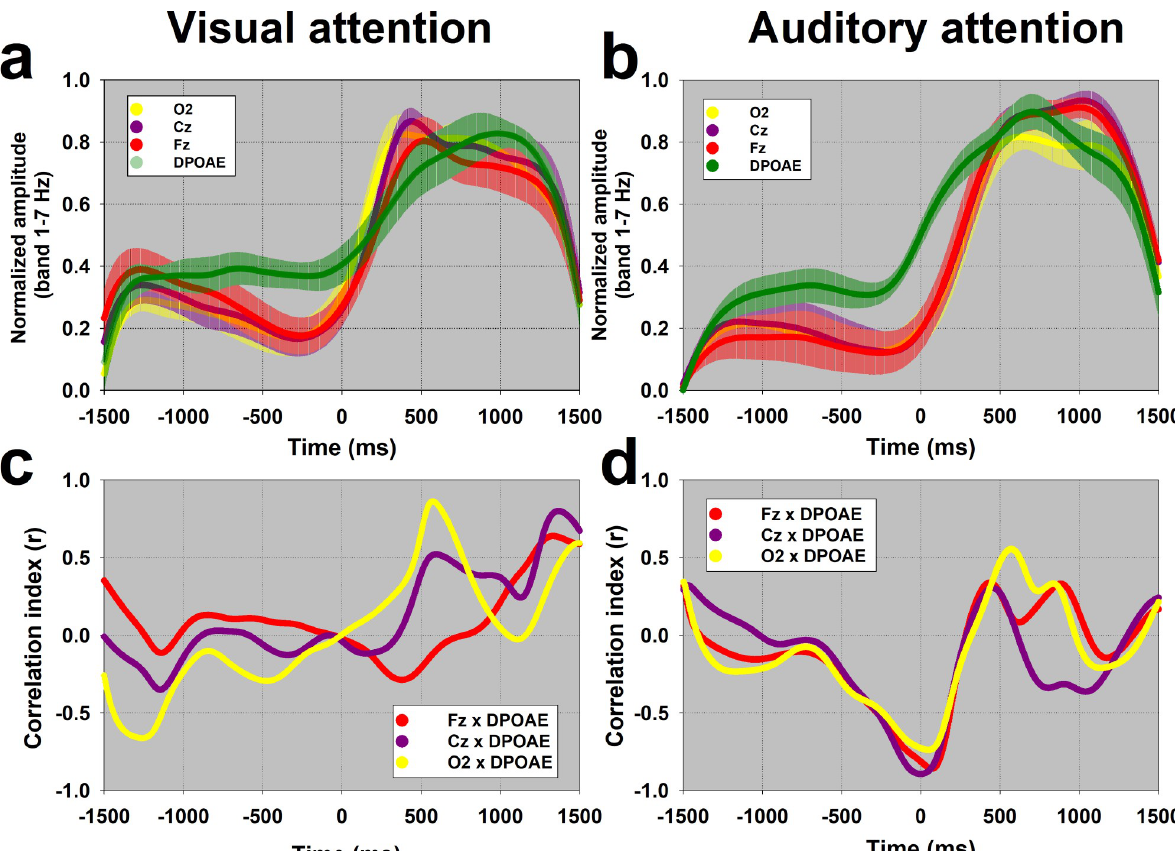
Fig 4. Temporal course and correlations of the amplitude of 1–7 Hz frequency band between EEG and DPAOE channels. The grand averages of the temporal course of the amplitude of the frequency band between 1 Hz and 7 Hz are shown in panels (a) and (b) for the visual and auditory attention tasks respectively (data shown as mean ± SEM). Notice that the DPAOE increment in the auditory attention task precedes those of EEG channels. The EEG and DPOAE curves shown in panel 4a,b were used to compute the half-time (50%) of the maximum oscillation amplitudes. Panels 4c and 4d show the temporal course of the Pearson correlation value (r) between the amplitude of DPOAE and Cz, Fz and O2 channels. Notice that around 500 ms there are positive correlations above 0.8 between DPAOE and O2 in the visual task, while in the auditory attention task there are significant negative correlations between DPOAE and EEG channels (~ -0.8) near 0